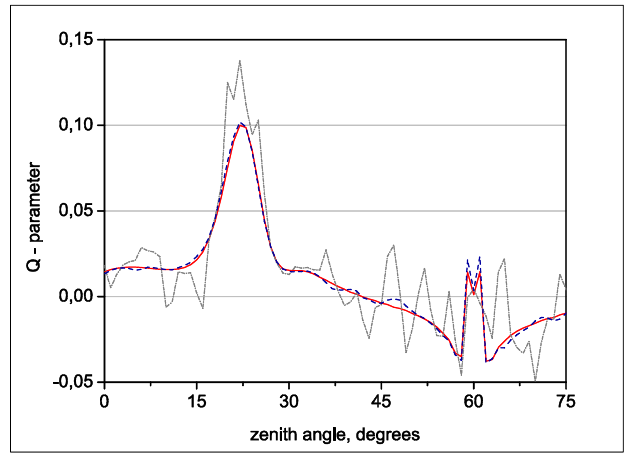
Figure 9. The normalized - Q- parameter calculated for the cloud model. Optical thickness = 5.0, SZA = 60°, relative azimuth = 180°. Red solid line—benchmark calculations, blue dashed and gray dashed-dotted lines—calculations using 10 5 photons with the transformed and initial scattering matrixes,